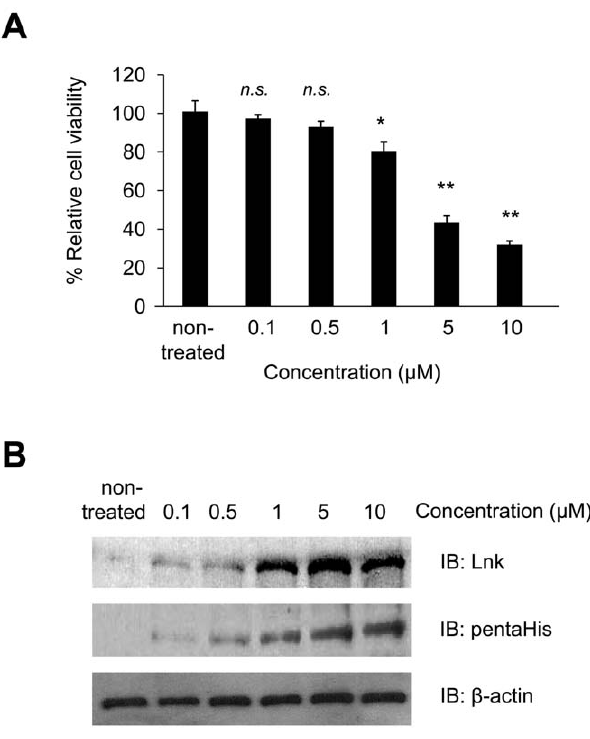
Figure 4. TPO-induced growth inhibition by WT Lnk R8 is dose- dependent. (A) Histogram showing percentages of M-MOK cell viability after treated with graded concentration of WT Lnk R8 relative to non-treated cells. Cell viability was determined at 48 hours after TPO stimulation through MTT assays. ( n.s. : not significant; Data represent mean 6 SD and results are representative of three independent experiments, *p , 0.05, **p , 0.01 ). (B) Western blotting data showing dose-dependent increment of delivered WT Lnk R8 proteins in M-MOK cells. Anti-Lnk antibody was used to probe both endogenous and intracellularly delivered Lnk proteins, whereas anti-pentaHis antibody probing showed delivered WT Lnk R8 proteins only. Anti- b -actin served as loading control.